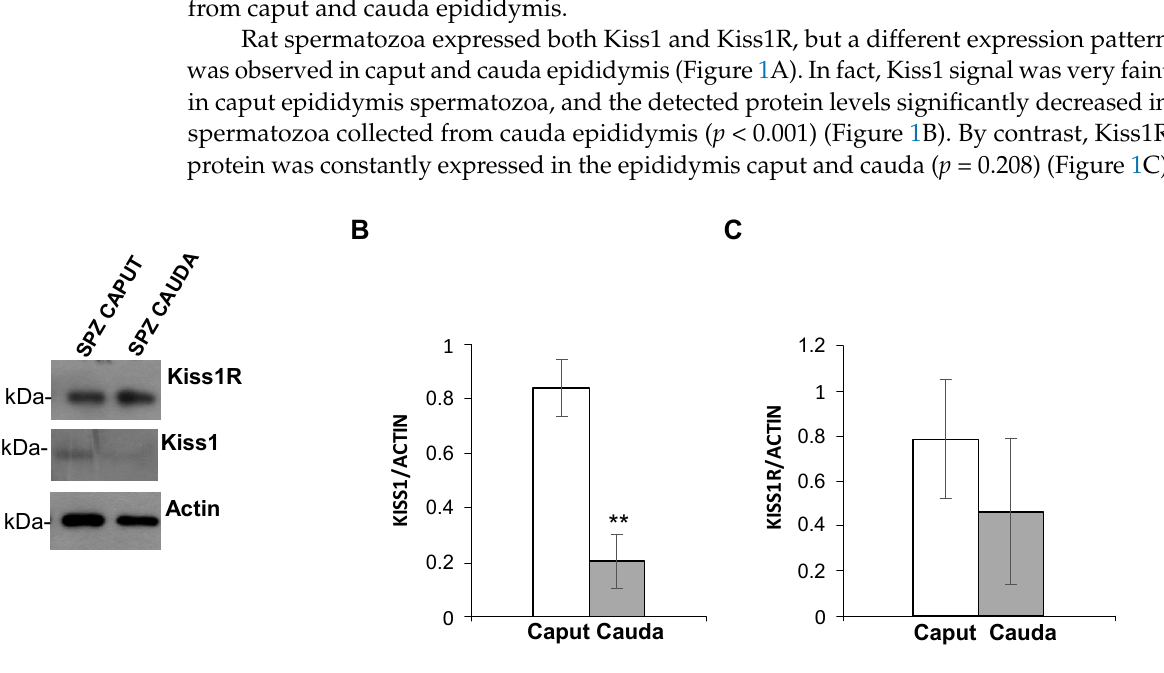
Figure 2. Confocal representative images showing immunofluorescence staining for Kiss1R (Ab- Kiss1R, green) in rat spermatozoa collected from epididymis caput ( A–C ) and cauda ( D–E ). DAPI (blue) was used to counterstain sperm cell nuclei. Scale bar: 5 µm ( A–C ); 7.5 µm ( D–F ).